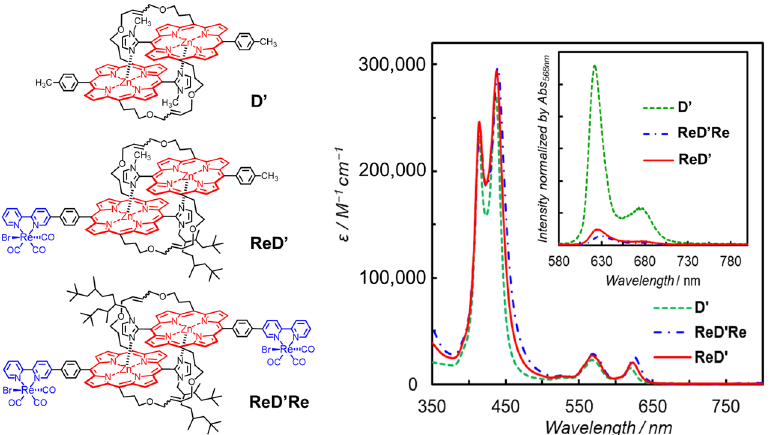
Figure 12. ( Left ) Chemical structures of the porphyrin dimers without ( D ′ ) and with the Re com- plex(es) ( ReD ′ Re and ReD ′ ). ( Right ) UV–vis absorption spectra of D ′ , ReD ′ Re , and ReD ′ in DMA. The inset presents fluorescence spectra of D ′ , ReD ′ Re , and ReD ′ in DMA at 298 K. The UV–vis absorption spectra of D (cid:48) , ReD (cid:48) Re , and ReD (cid:48) (Figure 12 right) showed that the Soret band split into two peaks due to strong exciton coupling between the two porphyrins in the dimer [49]. In contrast, the Q band was negligibly small due to the smaller oscillator strength. The broader Soret band caused by the exciton coupling enables the use of a very wide wavelength range of visible light for photocatalytic reactions. The fluorescence spectra of ReD (cid:48) Re , and ReD (cid:48) (Figure 12 right) were significantly quenched in polar DMA (dielectric constant: ε s = 38.3) compared with D (cid:48) and the fluorescence quench- ing was not observed in less-polar toluene ( ε s = 2.43), indicating that the intramolecular electron transfer from the S 1 of porphyrin dimer to the Re complex occurs in ReD (cid:48) Re and ReD (cid:48) . This behavior is in contrast to ZnP-phen=Re . In addition, no room-temperature phosphorescence was observed in ReD (cid:48) Re and ReD (cid:48)